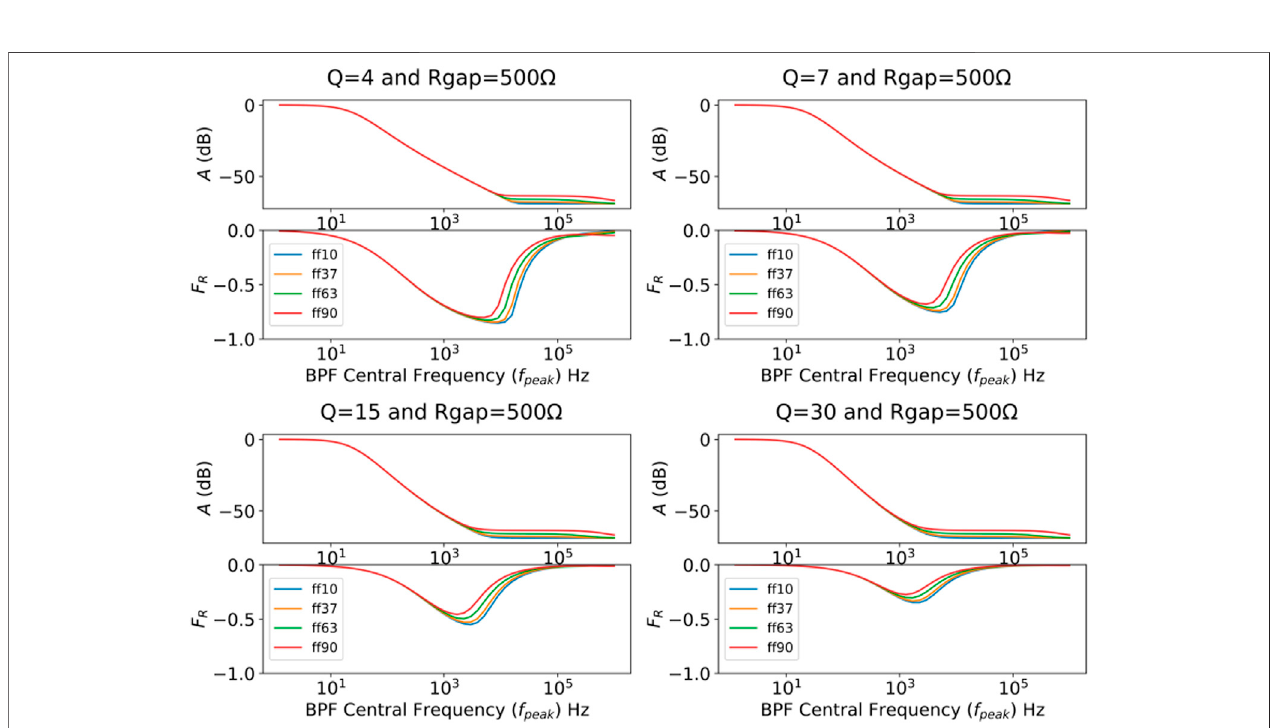
FIGURE7| Oscillation-Based (OB)Spectroscopysystemfordifferentvaluesof Q f parameter,witha fi xedR gap (cid:2) 500.Thesimulationsareperformedoverdifferent fi ll factor levels (10%, 37%, 63%, and 90%).